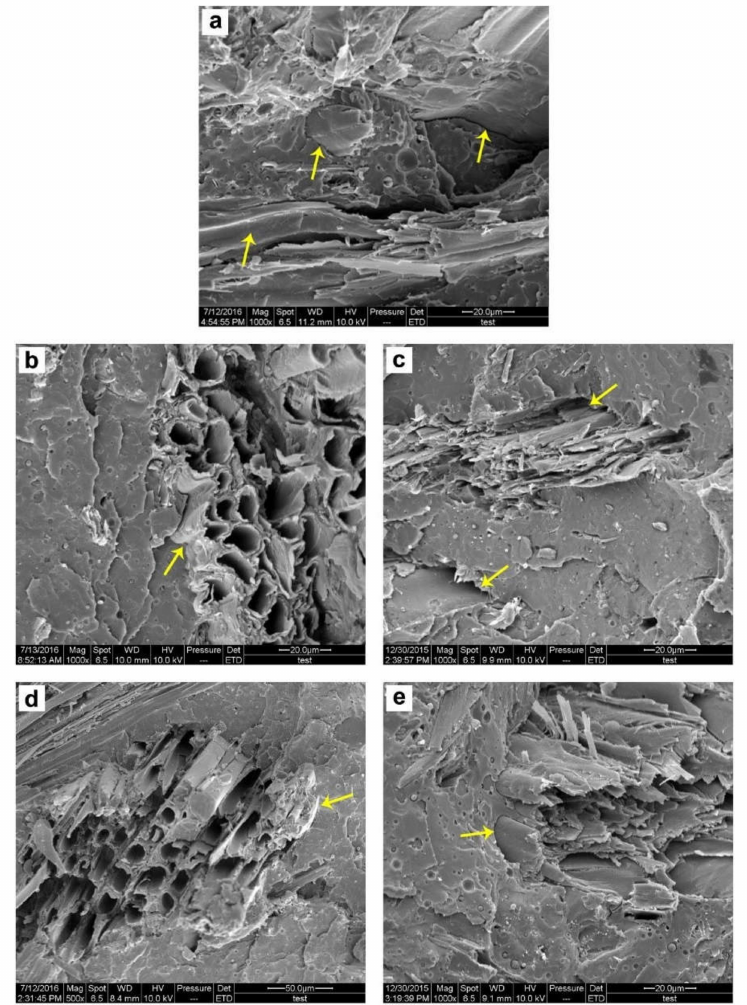
Figure 7. The morphology of the PLA composites with unmodified poplar fiber ( a ), 2% KH550-modified poplar fiber ( b ), 8% KH550-modified poplar fiber ( d ), 0.5% MA-modified poplar fiber ( c ), and 4% MA-modified poplar fiber ( e